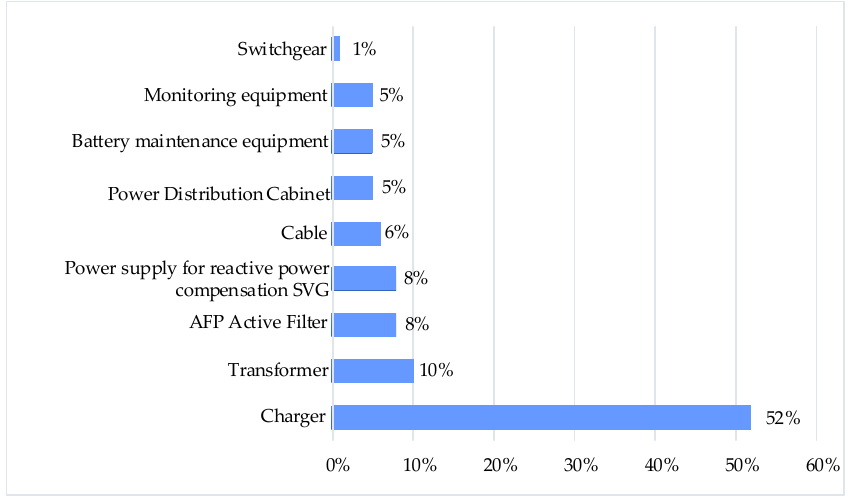
Figure 22. Construction cost analysis diagram of slow-charging piles .